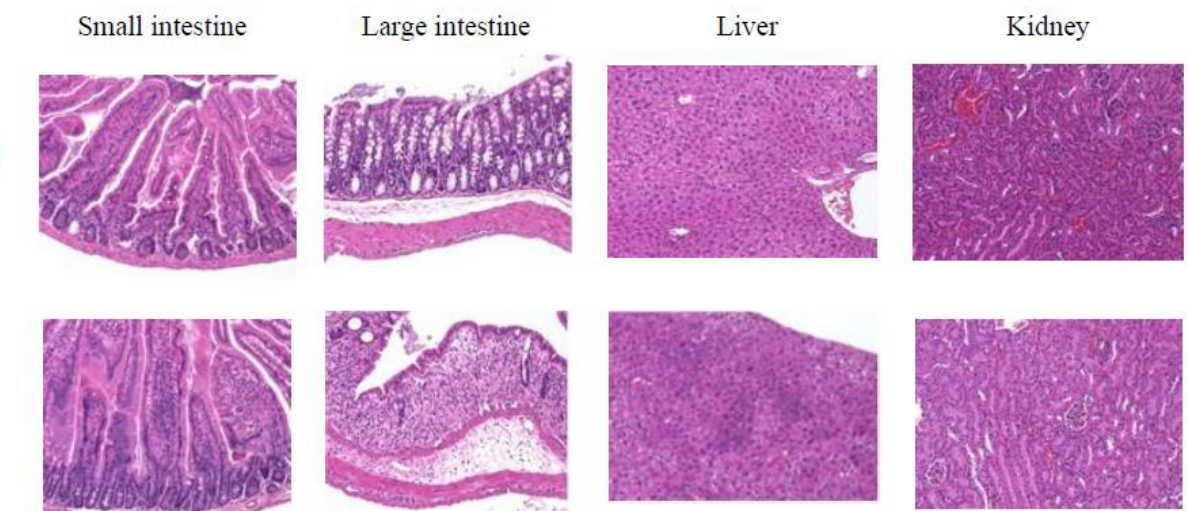
Figure 4. Anti-OCTN1/2 immunohistochemical analysis in the small intestine, large intestine, liver, and kidney. Purple indicates expression of OCTN1/2. The DSS-induced experimental colitis mice show relatively lower expression of OCTN1/2 than control mice in the small and large intestine. DSS has no effect on the liver and kidney.